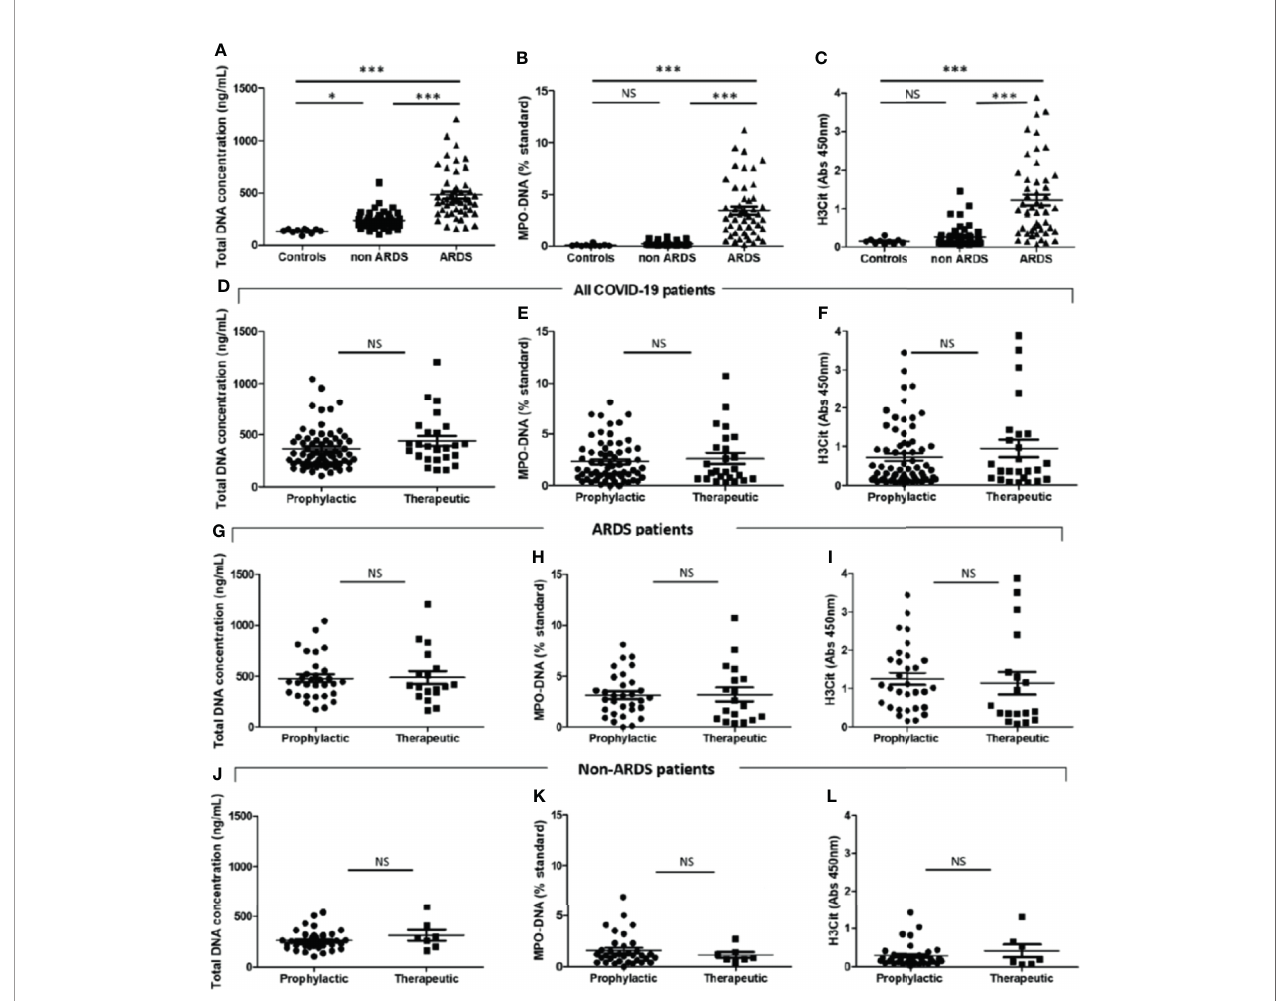
FIGURE 1 | Critically ill COVID-19 patients have higher plasma neutrophil extracellular trap (NET) levels than those of moderate COVID-19 patients and controls. Plasma NET levels were compared between healthy donors ( “ controls ” , n = 10), moderate [without acute respiratory distress syndrome (ARDS) “ non-ARDS ” ] COVID- 19 patients (n = 46), and patients with ARDS (n = 50) admitted to the intensive care unit. Levels of NET markers were as follows: plasma total DNA concentrations [140 ng/ml (124 – 151) vs. 220 ng/ml (188 – 271) vs. 428 ng/ml (324 – 560), p < 0.0001], plasma MPO – DNA levels [0.044 ST (0.012 – 0.093) vs. 10.15 ST (0.10 – 0.31) vs. 3.00 (1.38 – 4.63), p < 0.0001] and plasma H3Cit levels [0.14 (0.088 – 0.18) vs. 0.17 (0.10 – 0.30) vs. 0.97 (0.41 – 1.75), p < 0.0001]. (A) Total DNA concentration (ng/ml). (B) Myeloperoxidase – DNA levels (% standard NETs). (C) Histone H3 citrullinated (absorbance 450 nm). Plasma NET levels were compared between COVID-19 patients treated with prophylactic (n = 71) or therapeutic (n = 25) heparin treatment. (D) Total DNA concentration (ng/ml). (E) Myeloperoxidase – DNA levels (% standard NETs). (F) Histone H3 citrullinated (absorbance 450 nm). Plasma NET levels were compared between COVID-19-related ARDS patients treated with prophylactic (n = 32) or therapeutic (n = 18) heparin treatment. (G) Total DNA concentration (ng/ml). (H) Myeloperoxidase – DNA levels (% standard NETs). (I) Histone H3 citrullinated (absorbance 450 nm). Plasma NET levels were compared between COVID-19 moderate patients treated with prophylactic (n = 39) or therapeutic (n = 7) heparin treatment. (I) Total DNA concentration (ng/ml). (J) Myeloperoxidase – DNA levels (% standard NETs). (K) Histone H3 citrullinated (absorbance 450 nm). Threshold for statistical signi fi cance was a p-value of 0.05. *p < 0.05, ***p < 0.0001. NS, statistically non-signi fi